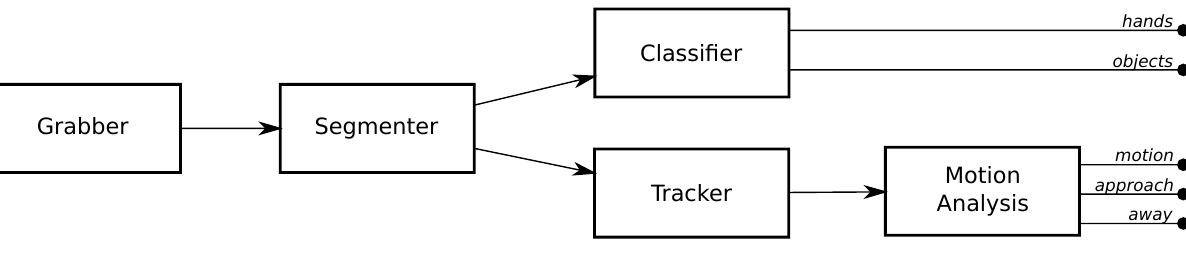
relative to the calibrated position. A neural-dynamic archi- tecture for calculating such transformations in real-time has been introduced recently